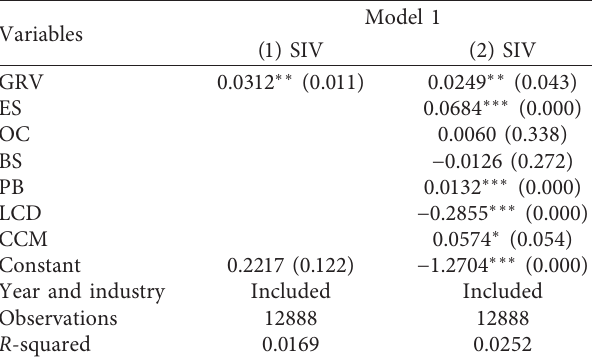
Table 4: Regression results of Hypothesis 1.